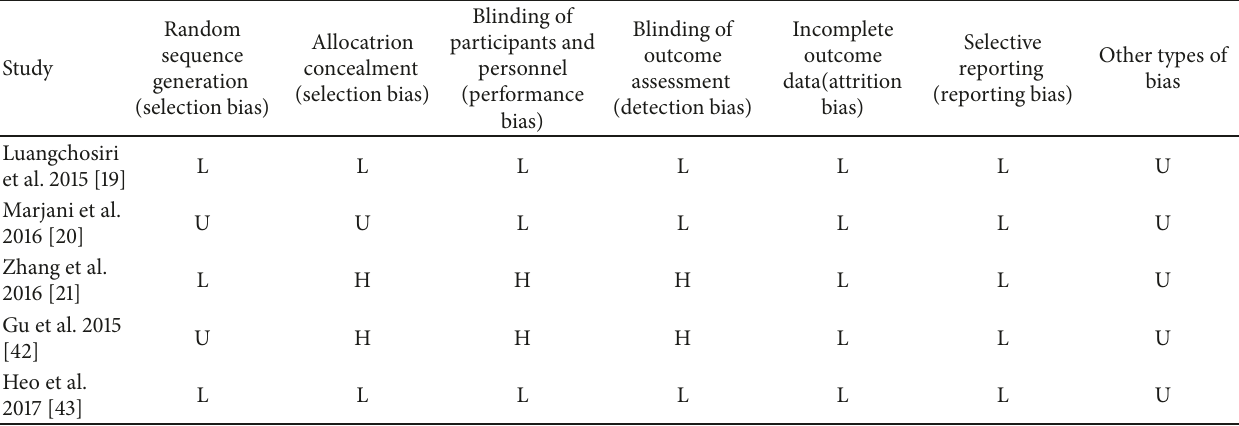
Table 2: Risk of bias assessment in the studies included for